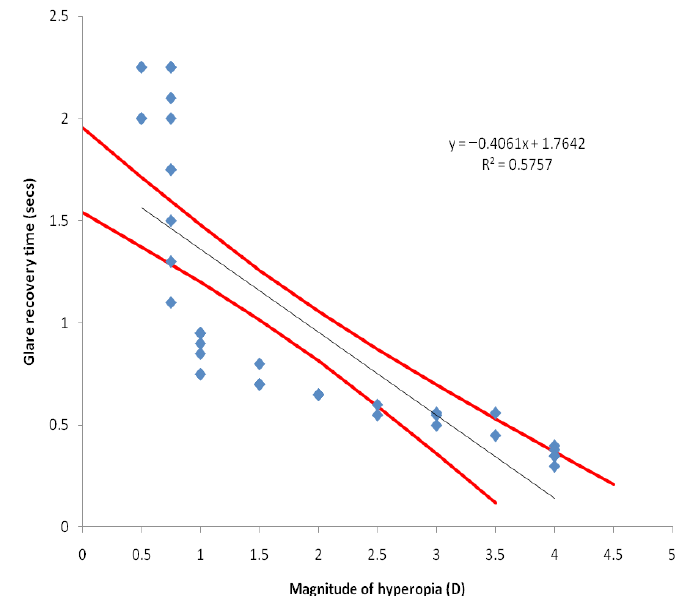
Figure 4: The scatter plots for the glare recovery time and mag- nitude of hyperopia. The solid straight line is the linear regres- sion to the data and the red lines represent the 95% confidence regions. Again, most of the coordinates are the same; hence many points